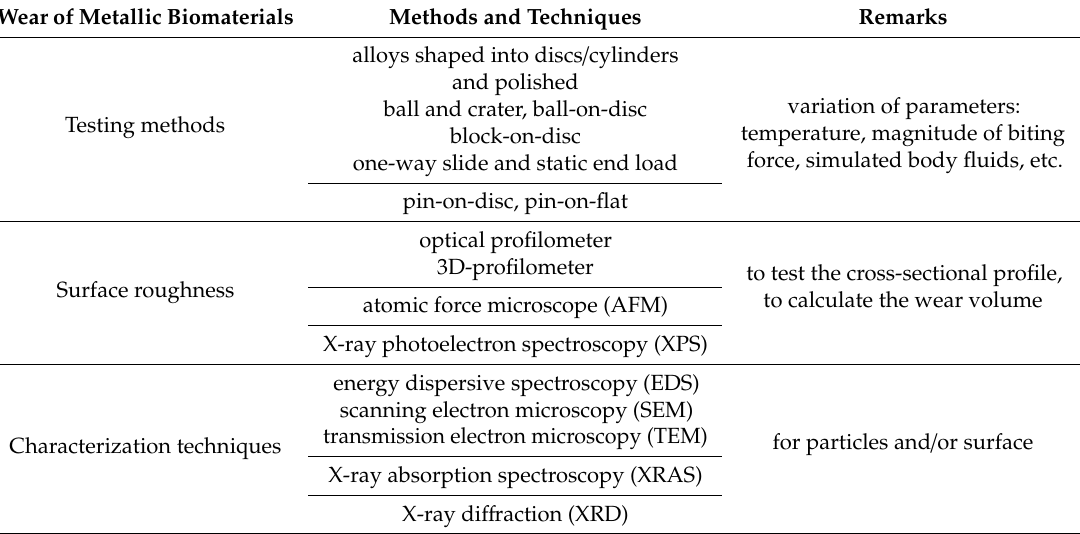
Table 3. Methods and techniques to study the tribological behavior of metallic biomaterials. Wear of Metallic